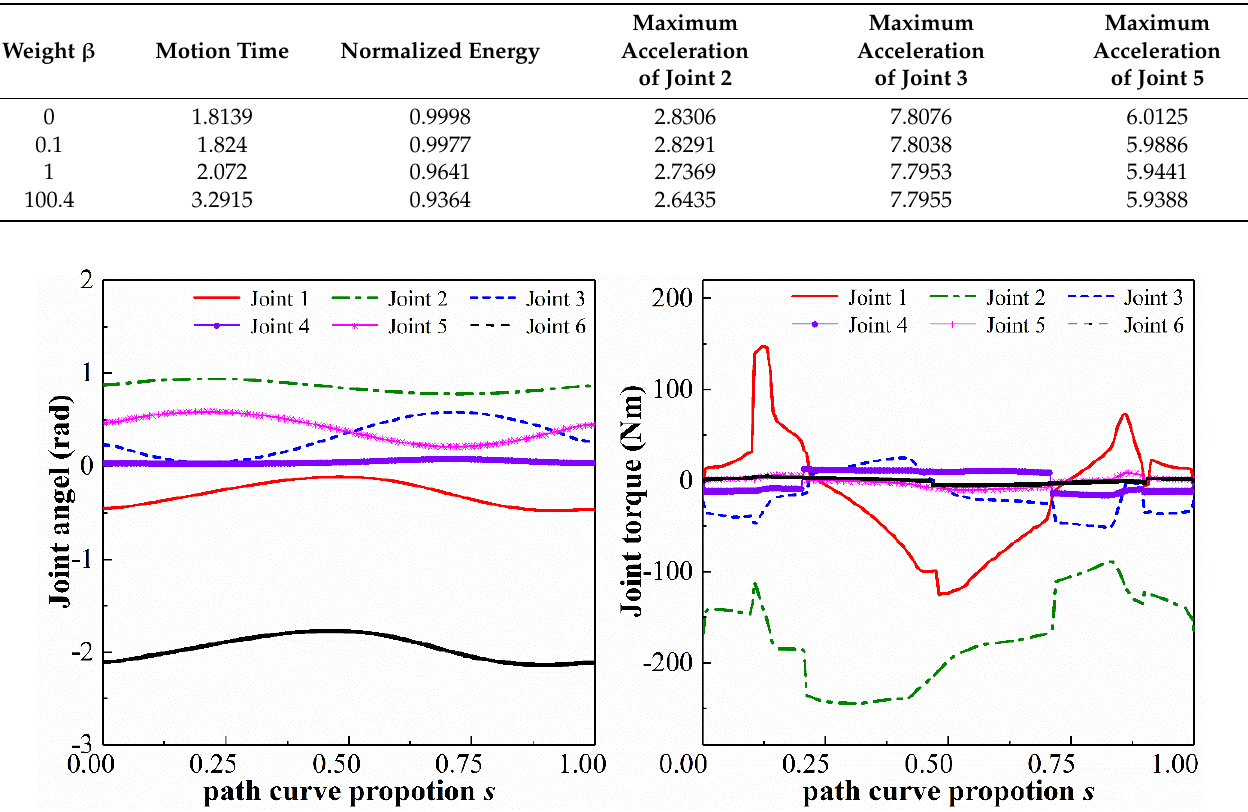
Figure 7. Optimized trajectories for robot joint with the proposed method when α = 0.1.